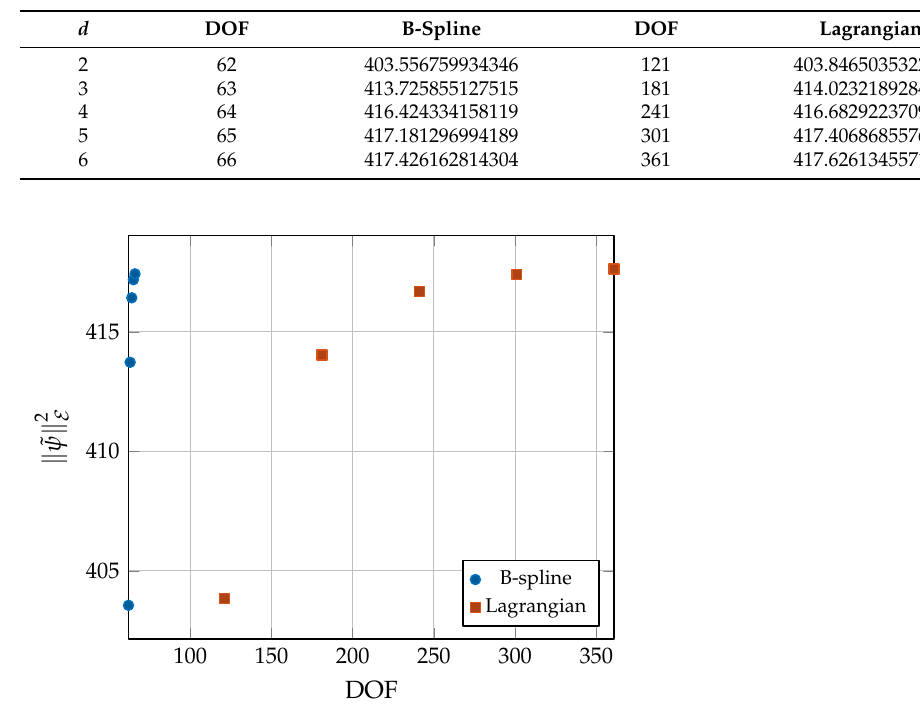
Figure 25. Squared space-time energy norm (60) of the approximated density on the S-shaped scatterer versus increasing B-spline degree (left) and refined time discretization (right).